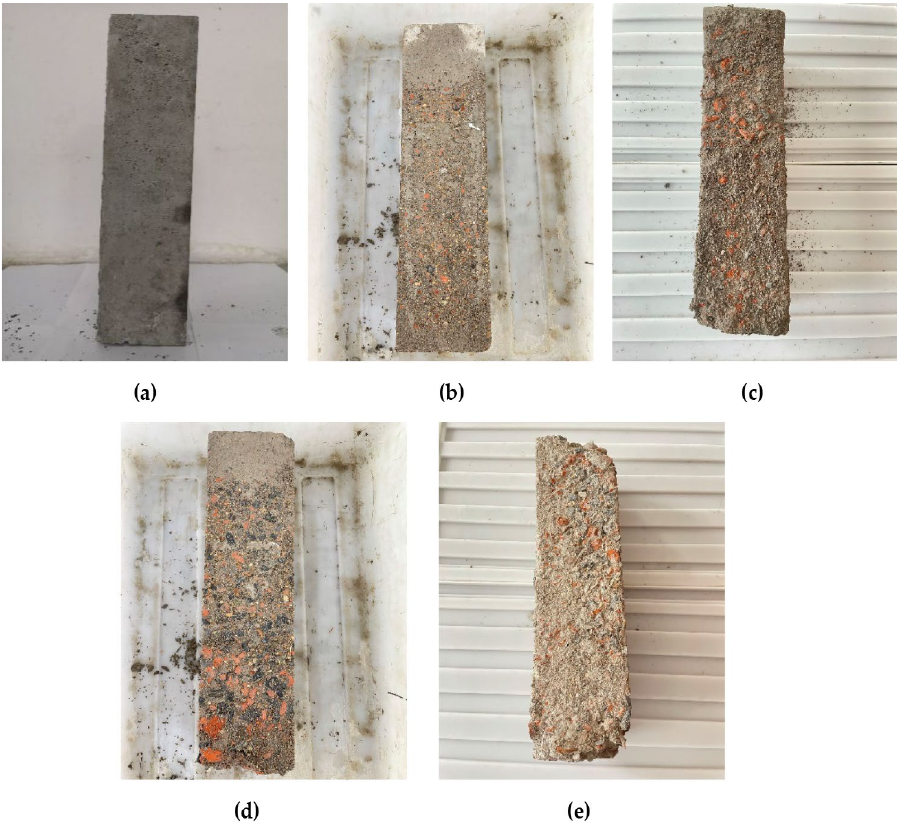
Figure 6. Specimen appearance after freezing and thawing: ( a ) Freeze–thaw 0 times; ( b ) Freeze–thaw 25 times; ( c ) Freeze–thaw 50 times; ( d ) Freeze–thaw 75 times; ( e ) Freeze–thaw 100